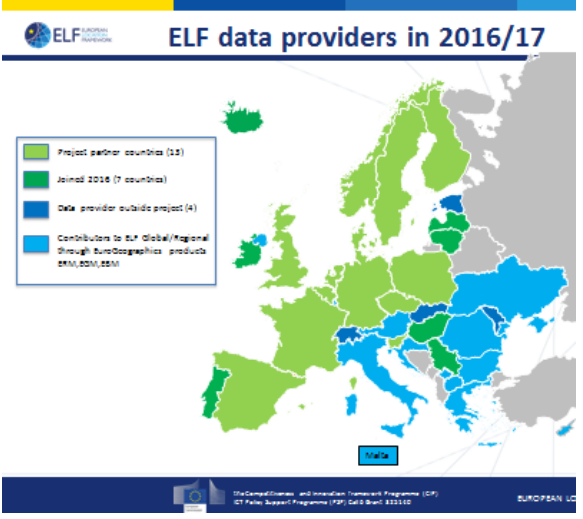
Figure 2. ELF Data Providers (as agreed in 2016)